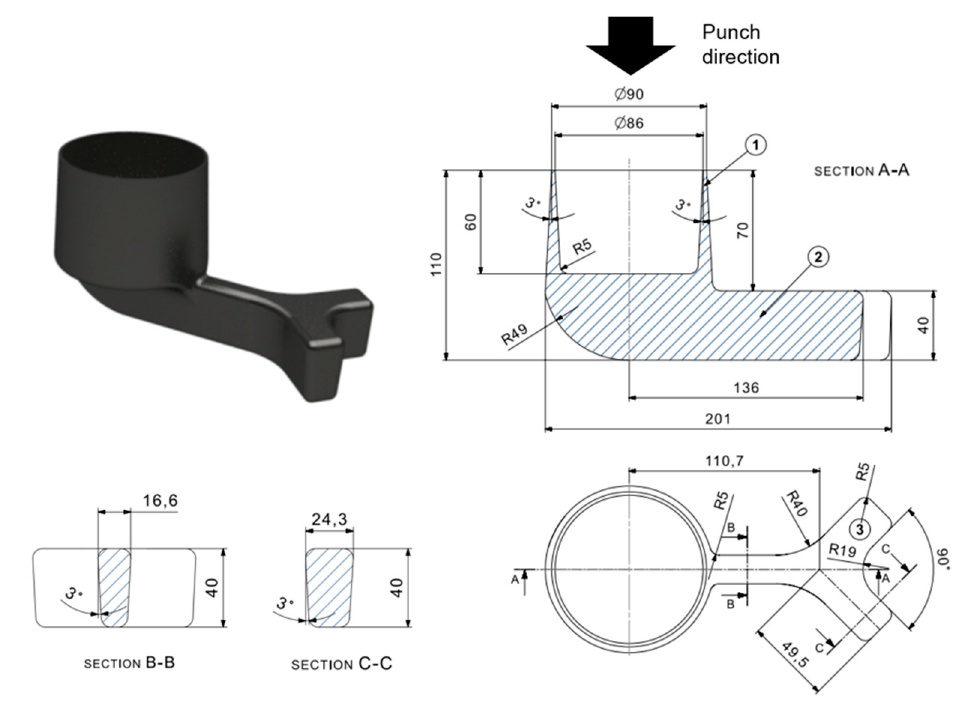
Figure 1. New component design to test the filling capabilities of the material during the Near Solidus Forming (NSF) process.